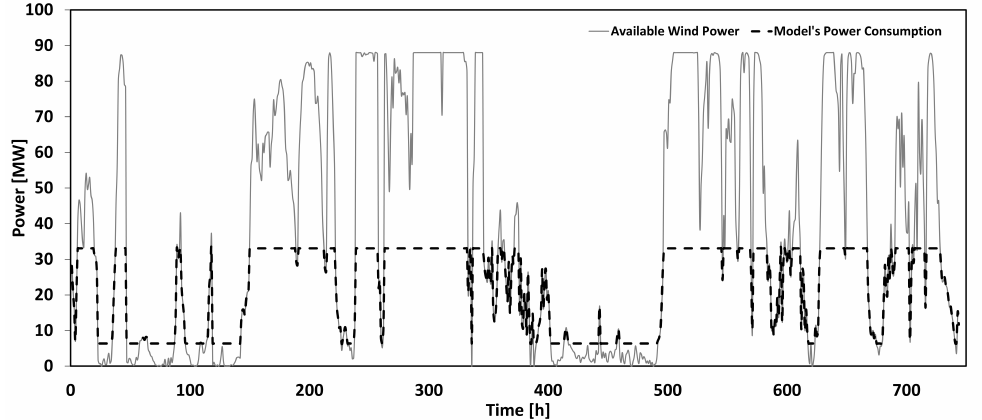
Figure 4. The model’s power consumption time series data together with the available wind power.